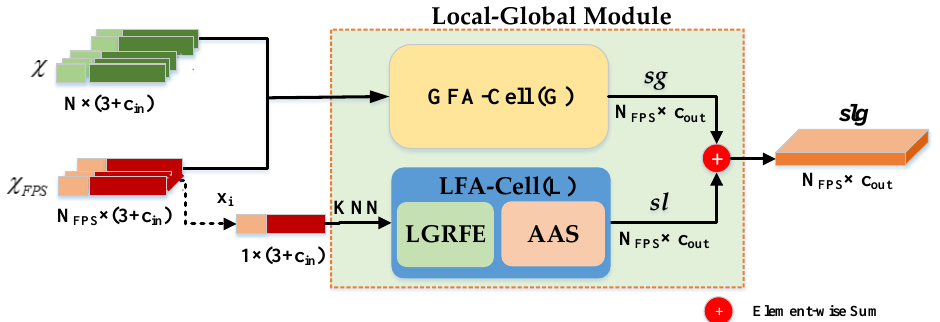
Figure 3. Local-global module. 𝑁 denotes the size of the point cloud 𝜒 , and 𝑁 𝐹𝑃𝑆 denotes the size of sampled point cloud 𝜒 𝐹𝑃𝑆 . 𝑐 𝑖𝑛 , 𝑐 𝑜𝑢𝑡 , and 𝑐 𝑓𝑖𝑛𝑎𝑙 stand for numbers of dimensions except for xyz -coordinates.